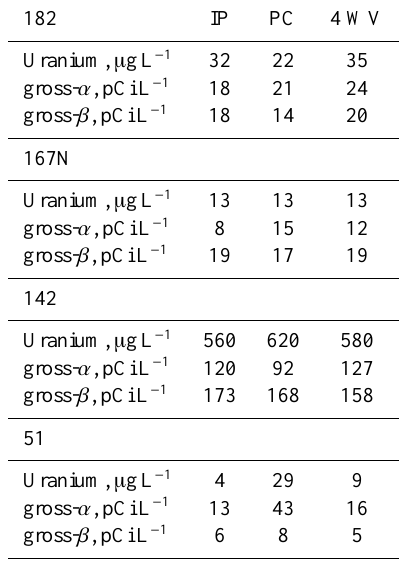
Table 6. Uranium, gross- α and gross- β results for three stages of treatment: IP (prior to chlorination), PC (post chlorination but prior to purging) and 4 WV (after purging 4 well vol- umes). The Maximum Contaminant Levels for uranium, gross- α and gross- β are 30 µ gL − 1 , 15pCiL − 1 and 4mremyr − 1 , re- spectively, (see http: // www.epa.gov / safewater / radionuclides / pdfs / qrg radionuclides.pdf, last accessed April 2010).